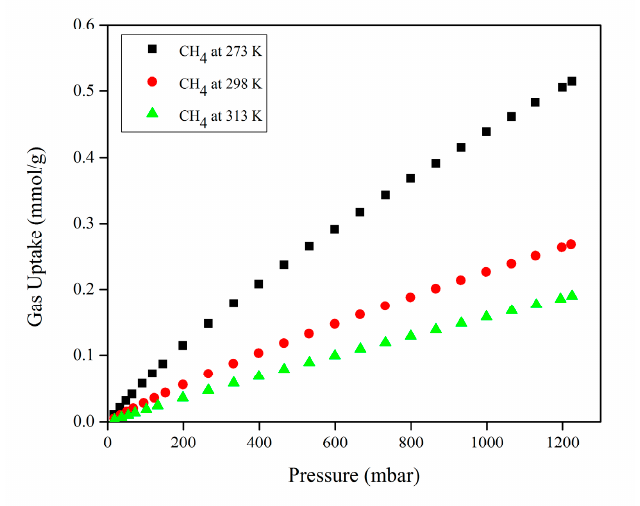
Figure 7. Experimental CH 4 single-component adsorption isotherms of Mg-gallate at 273, 298 and 313 K.